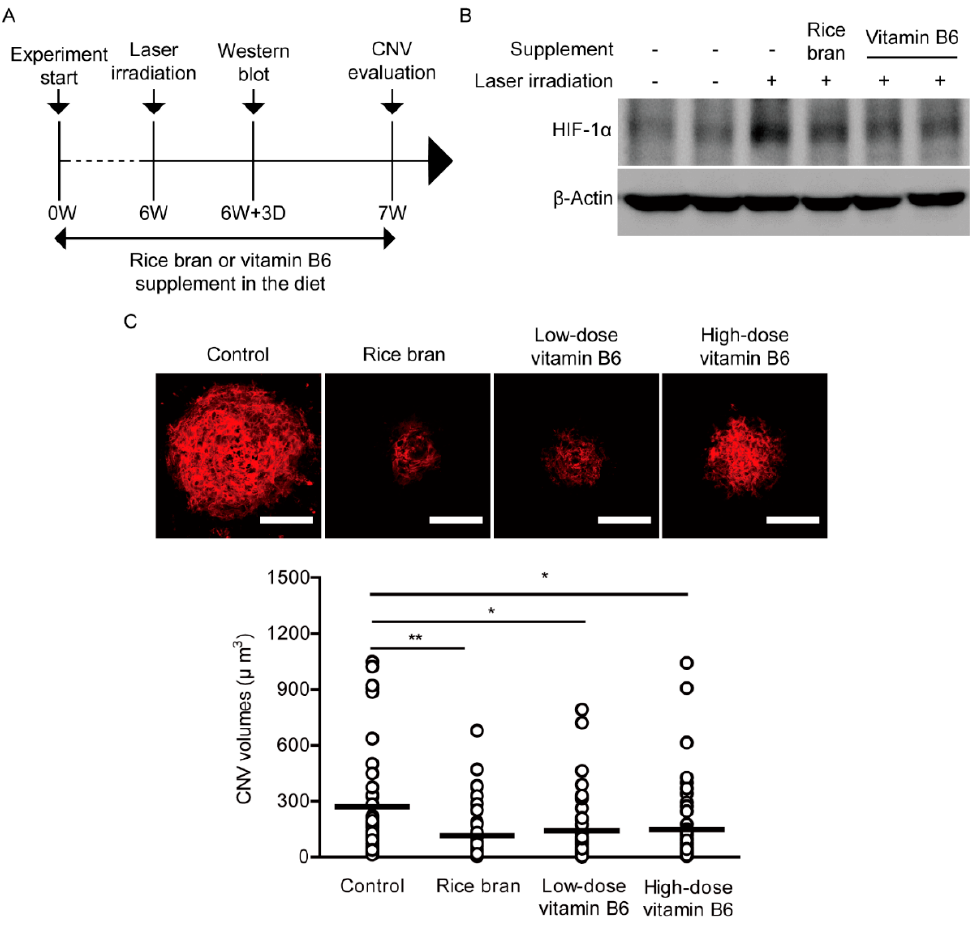
Figure 4. Suppression of neovascularization by rice bran and vitamin B6. ( A ) A schematic illustration demonstrates the murine choroidal neovascularization (CNV) model procedure and administration of rice bran or vitamin B6 to mice. ( B ) An immunoblot image for HIF-1 α and β -Actin in the retina with or without the supplement of rice bran or vitamin B6, 3 days after the laser irradiation. ( C ) Representative images of CNV in the whole mount staining with isolectin B4 and quantitative analyses ( n = 5–6 per group, n = 42–49 laser spots in the eyes per group) showed that the volume of CNV was significantly reduced by administration of rice bran (587.5 mg / kg diet weight) and vitamin B6 (9 or 35 mg / kg diet weight), respectively. Scale bars, 100 µ m. * p < 0.05, ** p < 0.01. Dot plot graphs were presented as mean. The data were analyzed using Student’s t ‐ test.